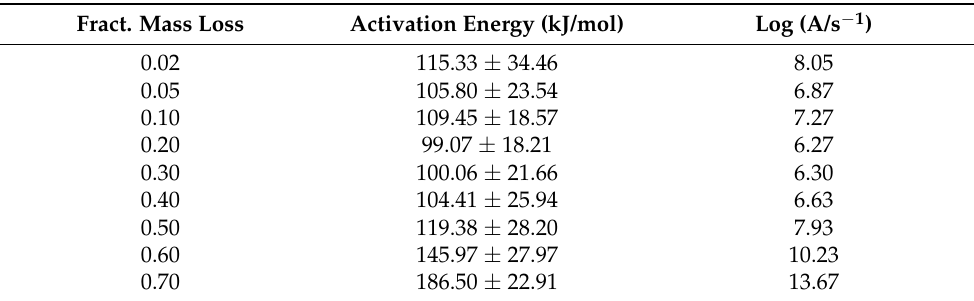
Figure 6. Presentation of the Ozawa–Flynn–Wall logarithm dx/dt function for Miscanthus. Table 3. Pre-exponential coefficient and activation energy as a function of the degree of conversion by the Ozawa–Flynn–Walla method for